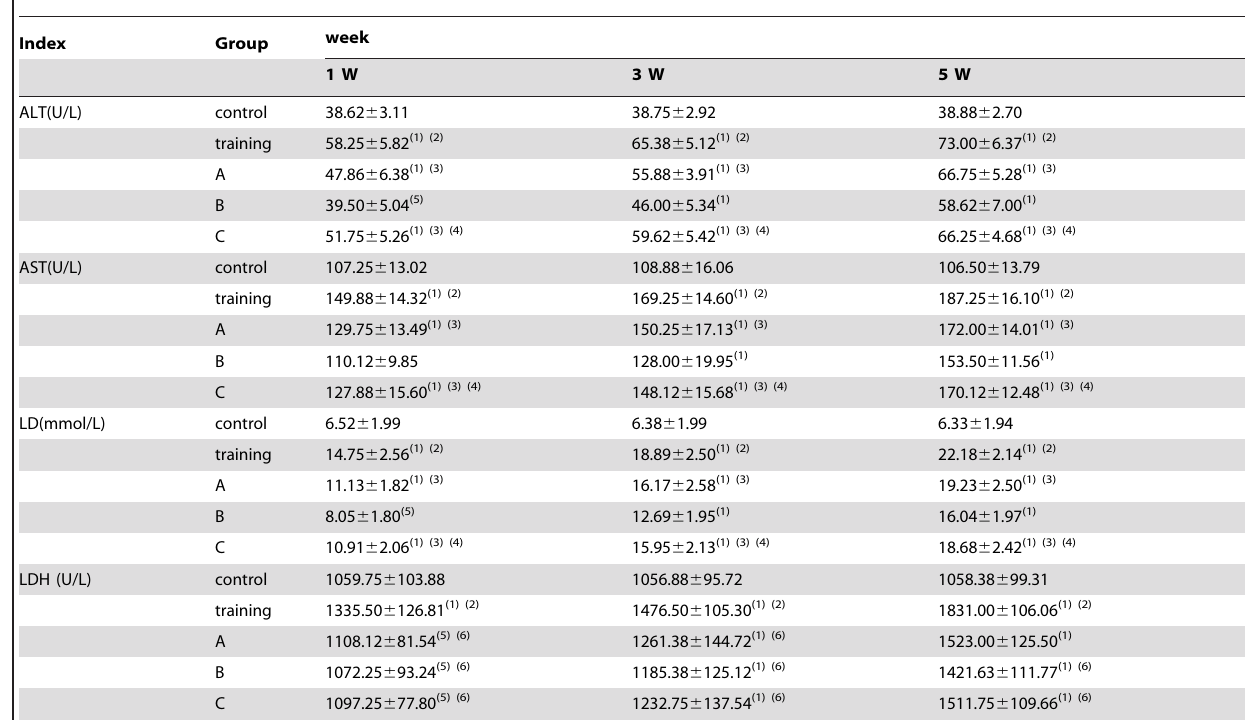
Table 2. Effect of pulse current on ALT, AST, LD and LDA in blood serum.